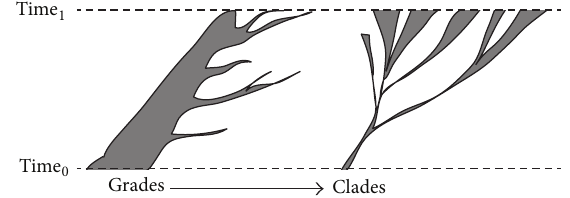
Figure 13: From grades to clades. The cartoon describes a possible progression of modes of organismal diversification during the rise of primordial archaeal lineages. The width of emerging lineages is proportional to uniquely identifying features of physiological and molecular